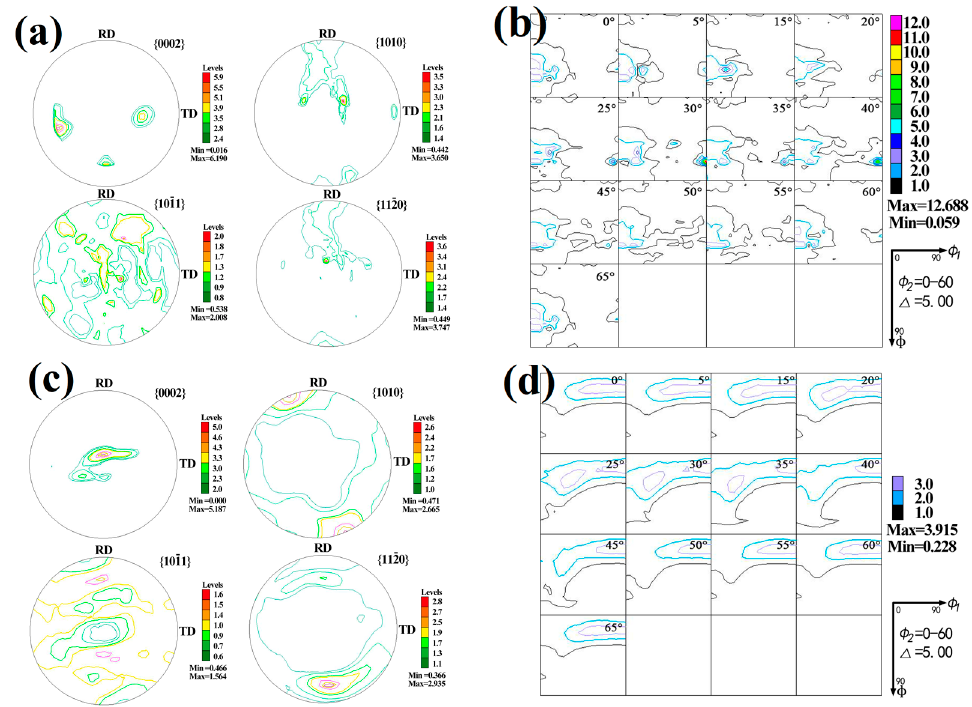
Figure 8. XRD texture analysis of the α -Mg phase of Mg-9Li alloys. ( a , b ) are polar diagram and ODF diagram of the E8 alloy, respectively; ( c , d ) are polar diagram and ODF diagram of the E8R alloy, respectively.